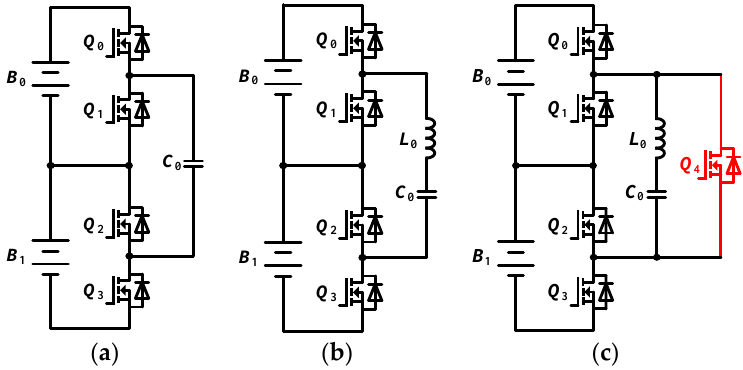
Figure 1. Battery equalizers based on switched-capacitor (SC) converters. ( a ) the classical SC equalizer [10]; ( b ) the resonant SC equalizer [15]; and ( c ) the proposed equalizer based on an inductor-capacitor-switch (LCS) converter.